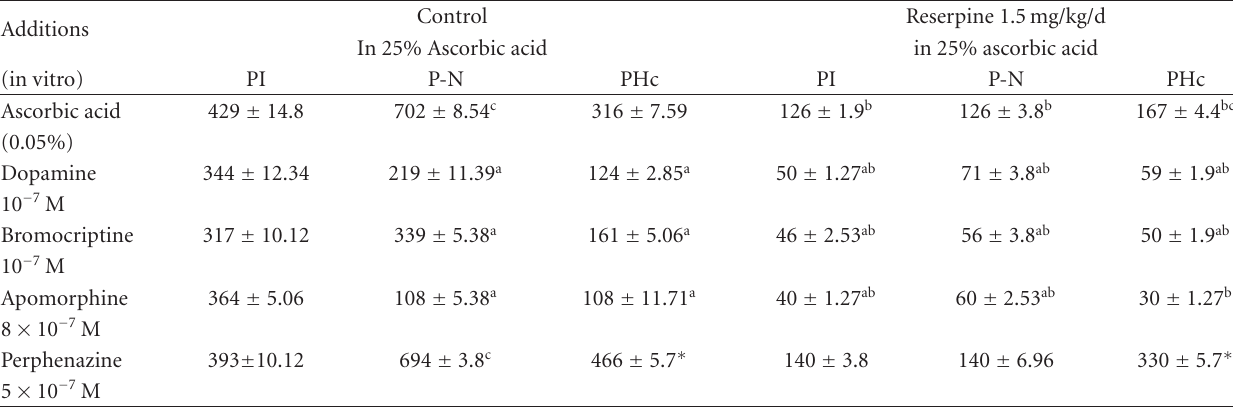
Table 2: E ff ects of reserpine on prolactin secretion by di ff erent pituitary constructs in response to dopamine agonists and antagonists in vitro.